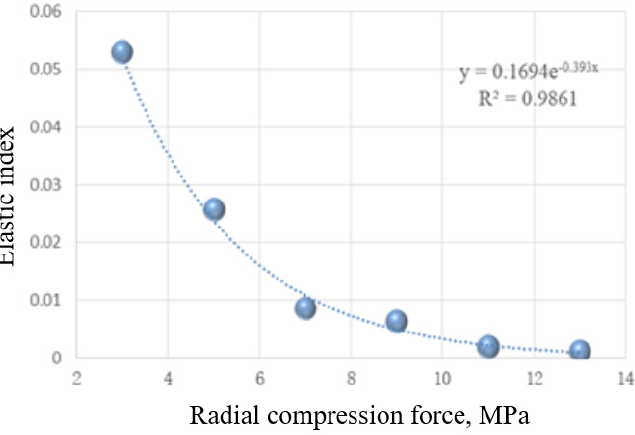
core went from elastic deformation to plastic deformation. went from elastic deformation to plastic deformation.